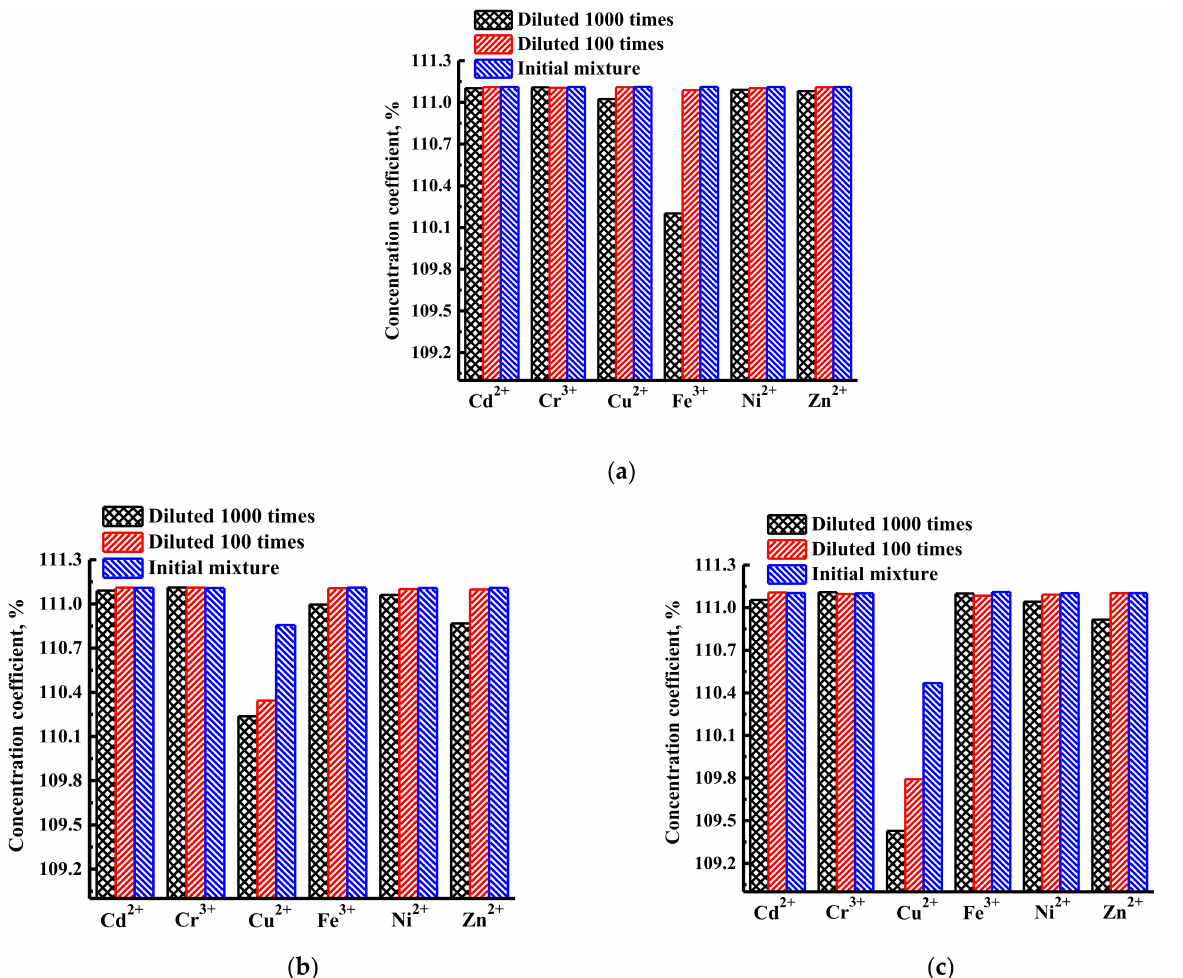
Figure 8. Concentration coefficients of heavy metal ions for ( a ) PIM-1, ( b ) PIM-1/MIL-125, and ( c ) PIM-1/MIL-140A membranes during the nanofiltration at 50 atm: a sample of untreated wastewa- ter (initial mixture), a sample of untreated wastewater, diluted 100 times, and a sample of untreated wastewater diluted 1000